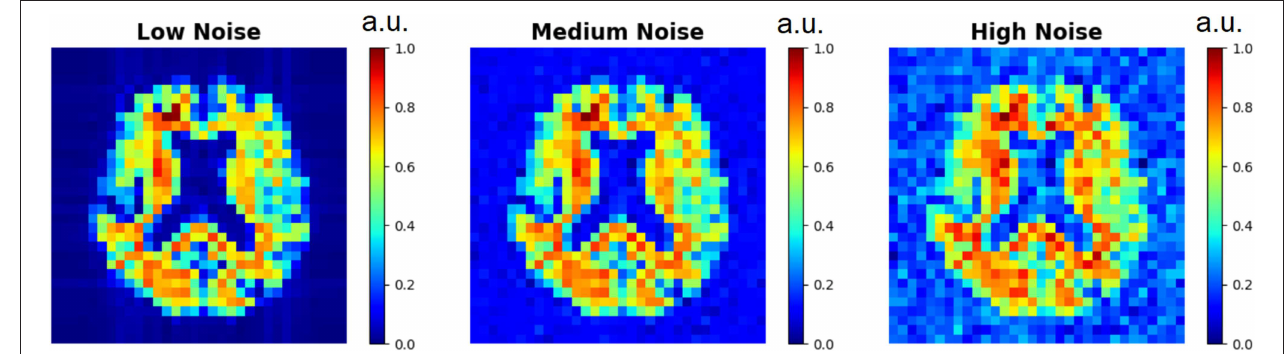
FIGURE 3 | Low resolution spectroscopic images generated using the SI generator are shown. To show the effect of different random noise levels, all other random parameters were the same between the three images. Low noise level, medium noise level, and high noise level were classified as 2–5, 15–20, and 30–40% of the maximum signal intensity, respectively.